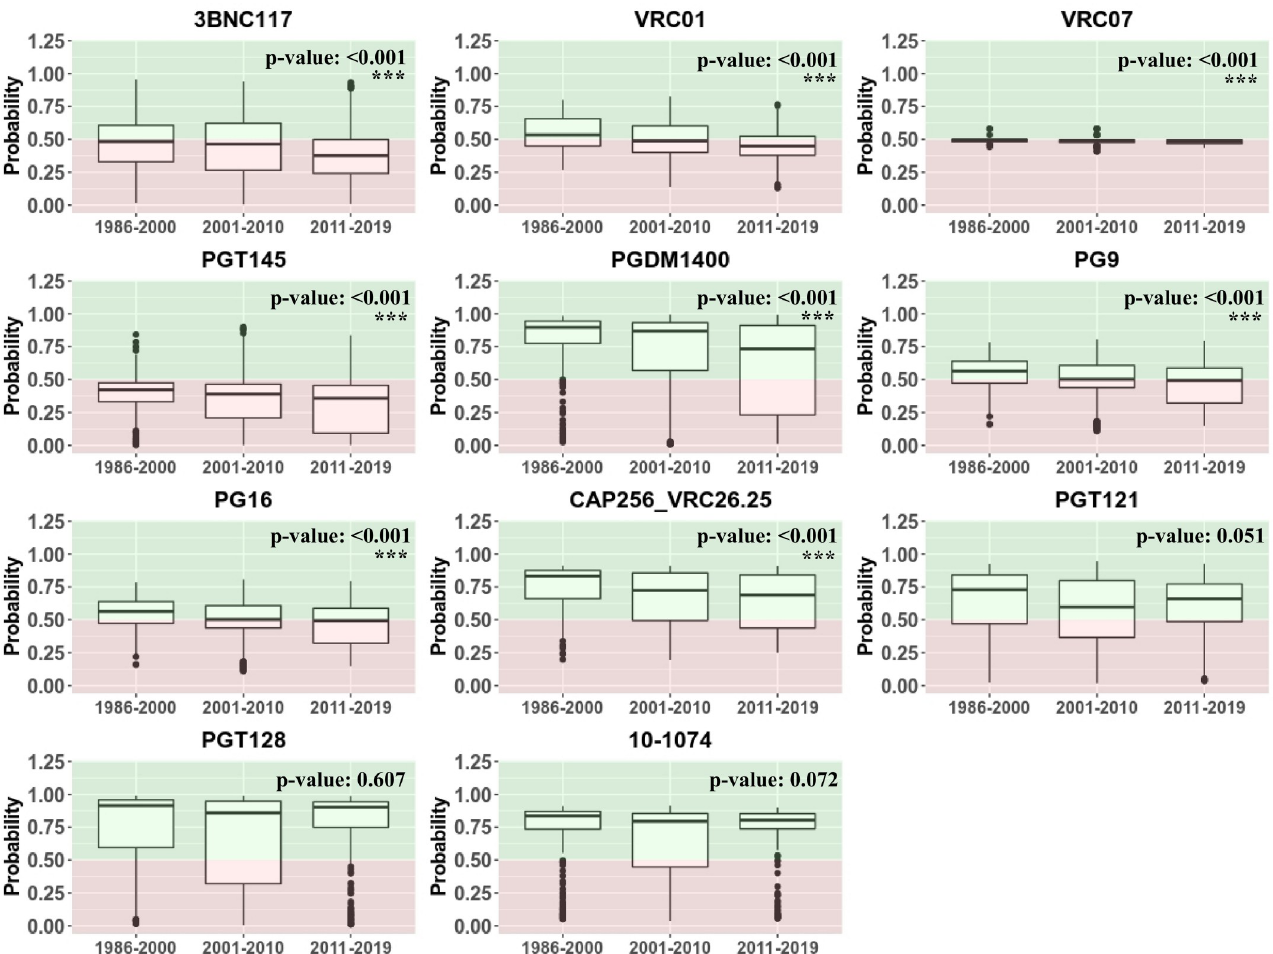
Fig 7. Assessment of predicted bnAb sensitivity over time. Each panel indicates cumulative prediction data for available sequences for 3BNC117, VRC01, VRC03, VRC07, VRC13, CAP256:VRC26.25, PGDM1400, PG9, PG16, PGT145, PGT121, and PGT128 and 10–1074 plotted against 3-time periods as